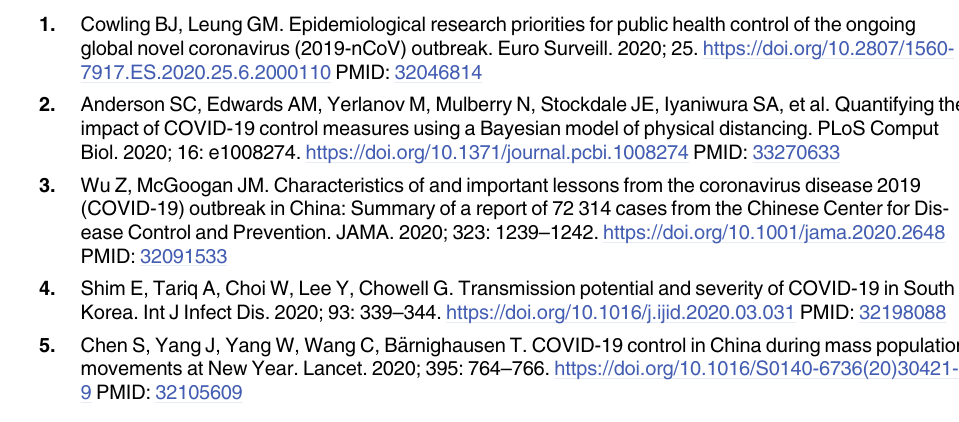
S1 Table. Initial conditions. Initial conditions representing moderate levels of prior immu- nity at the time of intervention change. All W classes and T classes are represented by W T , respectively. Increased levels of prior immunity were also considered in sensitivity analyses i (denoted by �